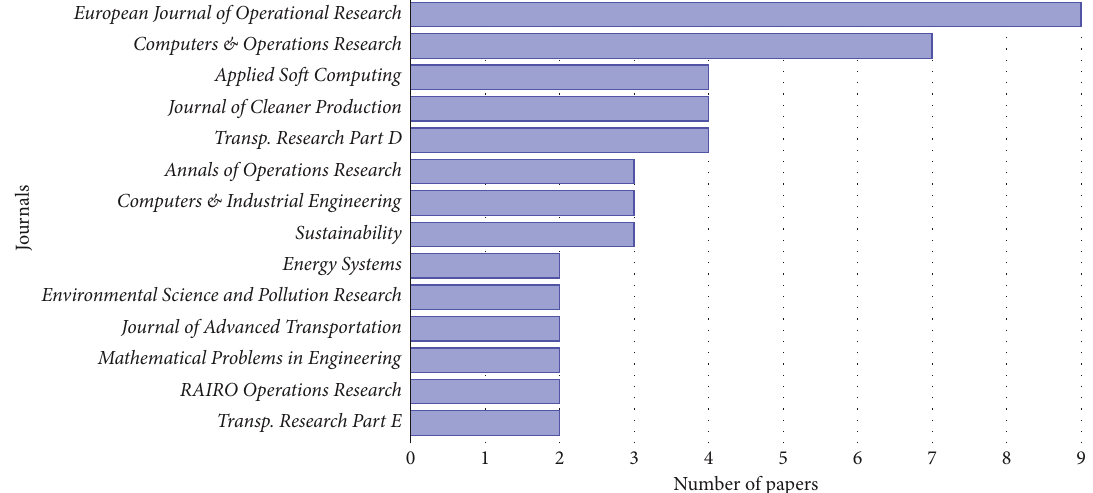
Figure 3: Number of papers published in (main) journals (note that the journals with more than two articles are shown).